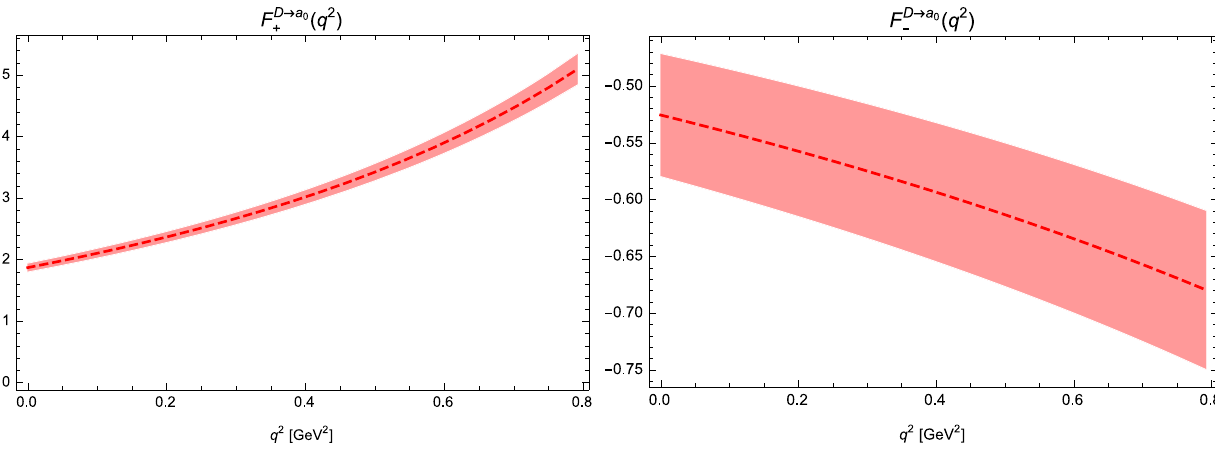
Fig. 5 F + ( q 2 ) (left) and F − ( q 2 ) (right) for the D 0 decay. The red bands reflect the uncertainty from the Borel parameter and the LECs of ChPT the terms proportional to b − ζ